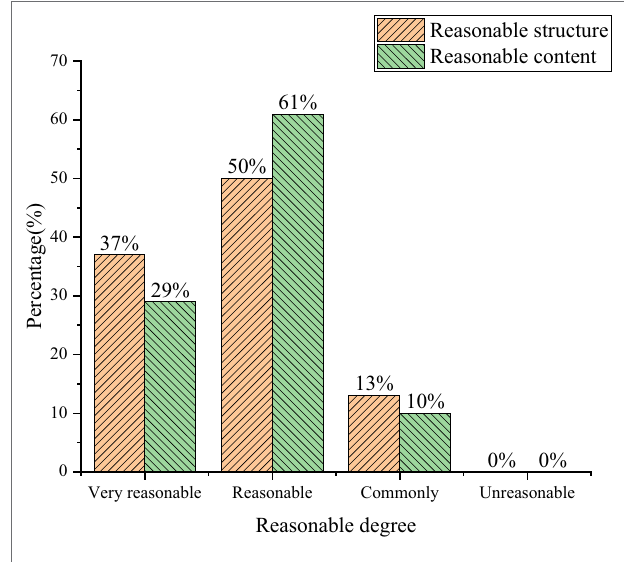
FIGURE 7 | The frequency table selected in the validity test.